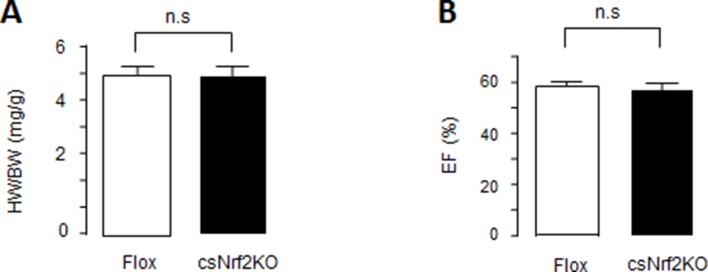
csNrf2KO mice exhibit normal cardiac morphology and function at baseline.(A) Heart weight/body weight ratio (HW/BW), and (B) Ejection fraction (EF). n.s: no significance. n = 5–6/group.